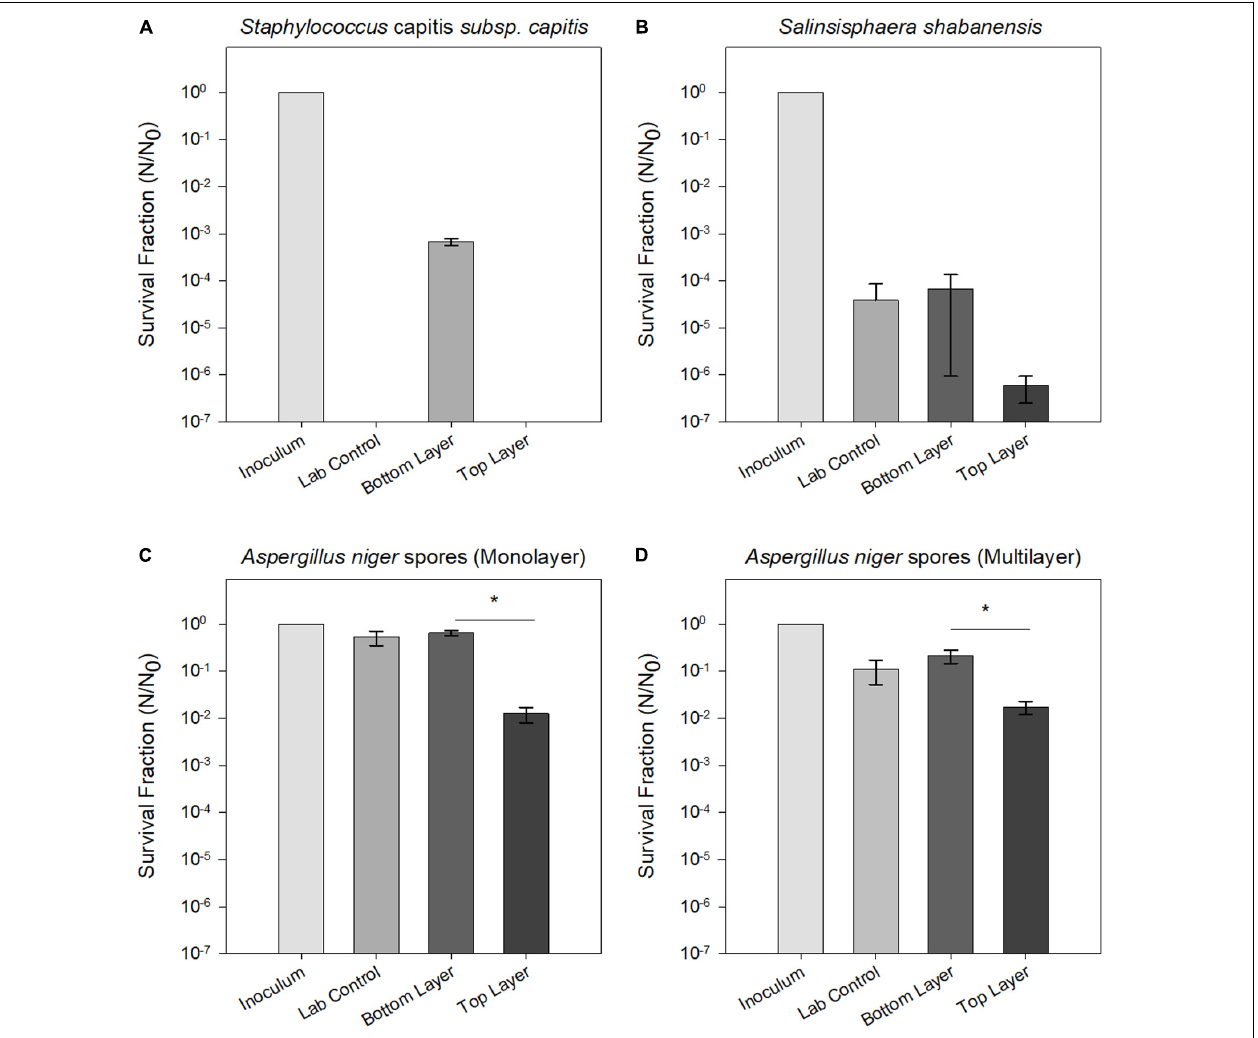
FIGURE 6 | Survival fraction (N/N0) of tested strains after exposure to Mars simulated conditions aboard the MARSBOx payload. (A) S. shabanensis (B) S. capitis subsp. capitis . (C,D) A. niger spores in monolayer (C) and in multilayer (D) . Data for Buttiauxella sp. MASE-IM-9 are not shown, since no surviving cells were recovered after